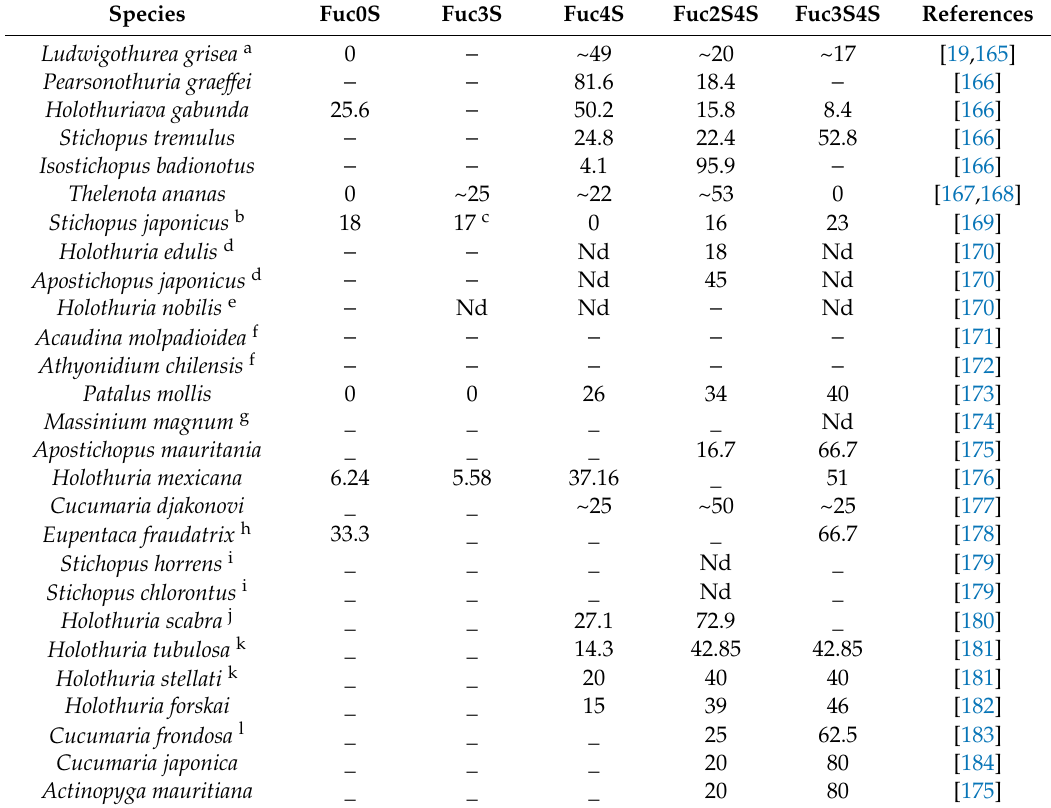
Table 3. Sulfation patterns (proportions of the branching sulfated fucose units) of FucCS from 27 sea cucumber species analyzed so